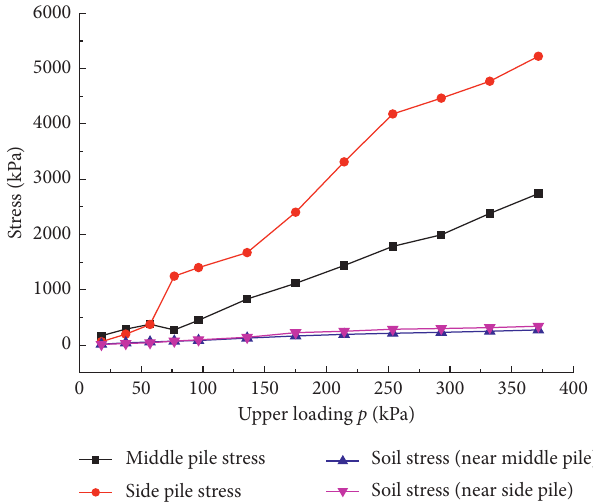
Figure 9: Changes of pile and soil stress with the growth of the upper load in the group pile composite